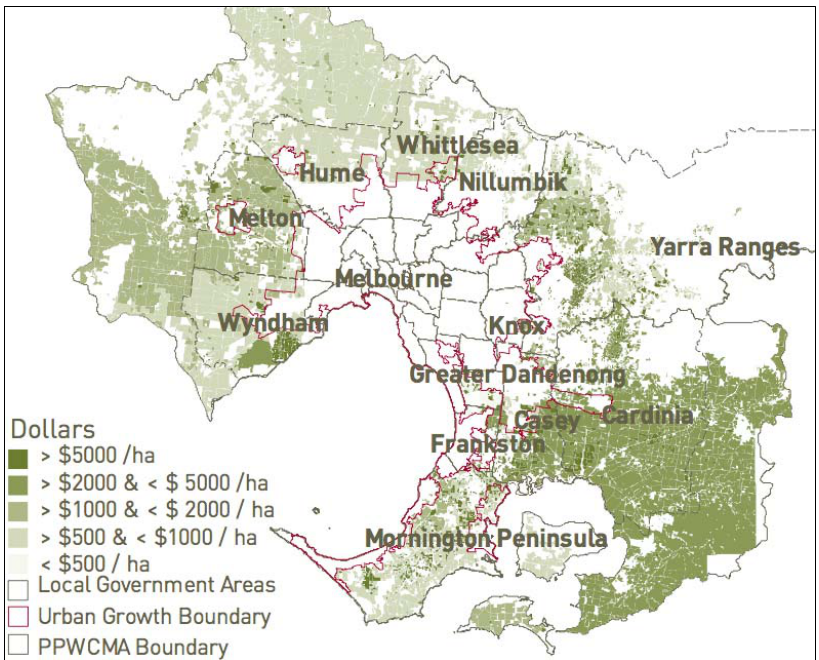
Figure 1. Agricultural Production in Victoria in